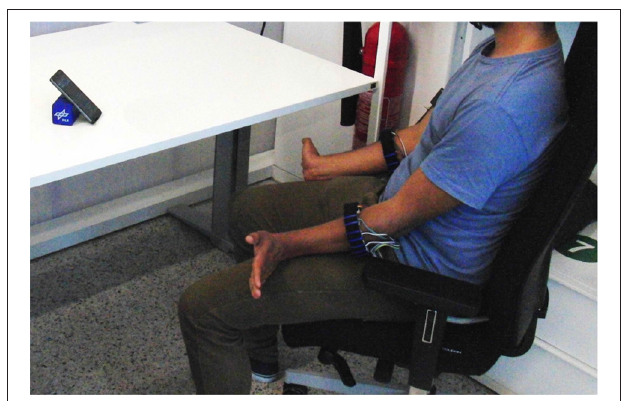
FIGURE 5 | A bird’s-eye view of the